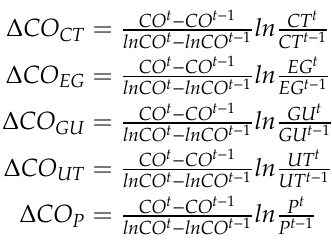
Figure 6. The accumulated effect of coal consumption drivers in Indonesia 1965–2017. In aggregate, the energy mix, urbanization, and the population contribute a positive influence on annual coal usage. The combined effect of these four drivers amounts to an increase of coal consumption by 57.03 MTOE. Among these, the energy mix effect (capturing the ratio of coal to total